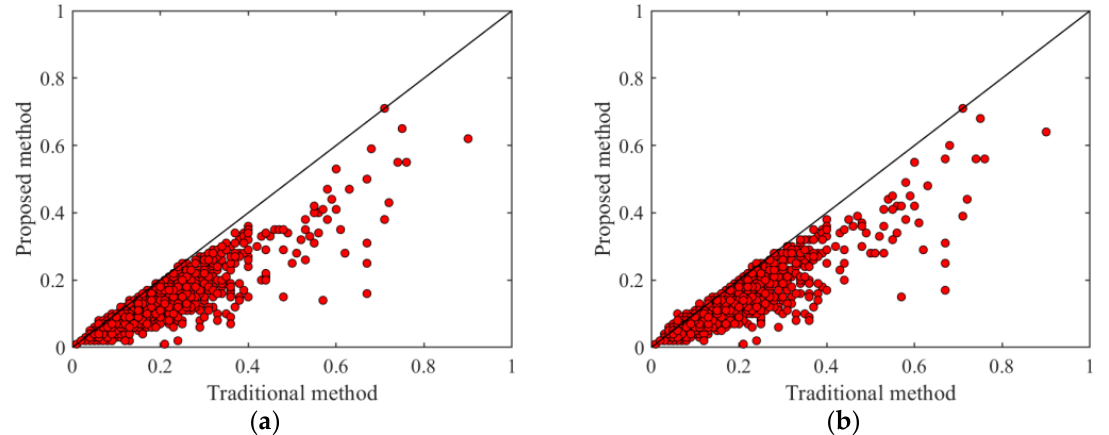
Figure 8. The high-pass cut-off frequency was obtained using a model that only trains the fully connected layer (unit: Hz). ( a ) The VGG19 when not considering probability; ( b ) the VGG19 when considering probability.